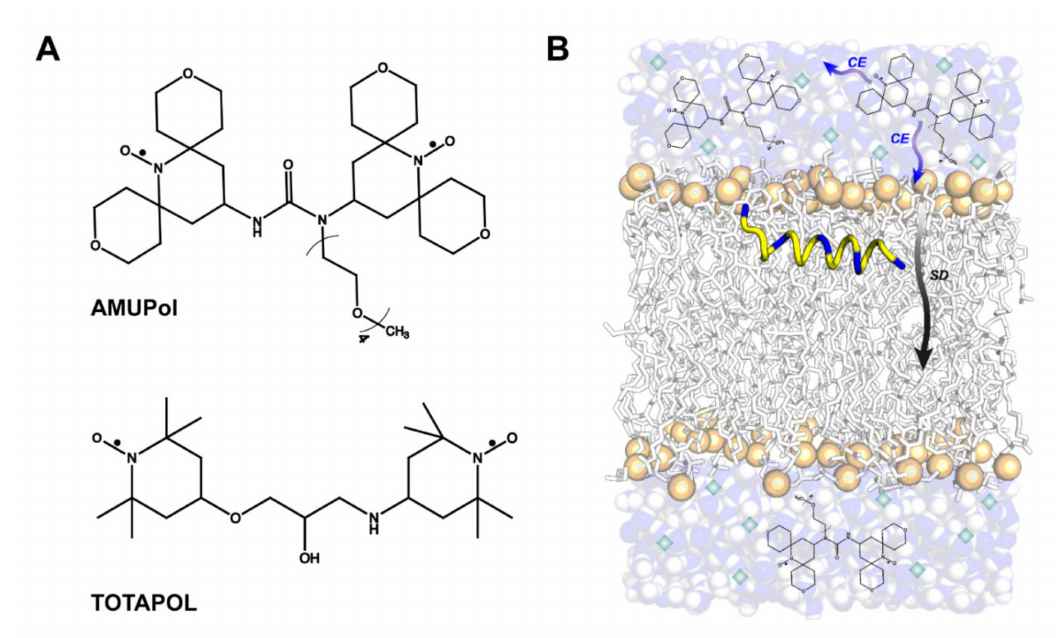
Figure 2. ( A ) Commercially available water-soluble biradicals for DNP. ( B ) Likely polarization transfer pathways via cross-e ff ect DNP (CE) and spin di ff usion (SD) in biomembrane samples incorporating AMUPol. Green diamonds indicate the presence of a glassing agent to maintain AMUPol dispersion during sample